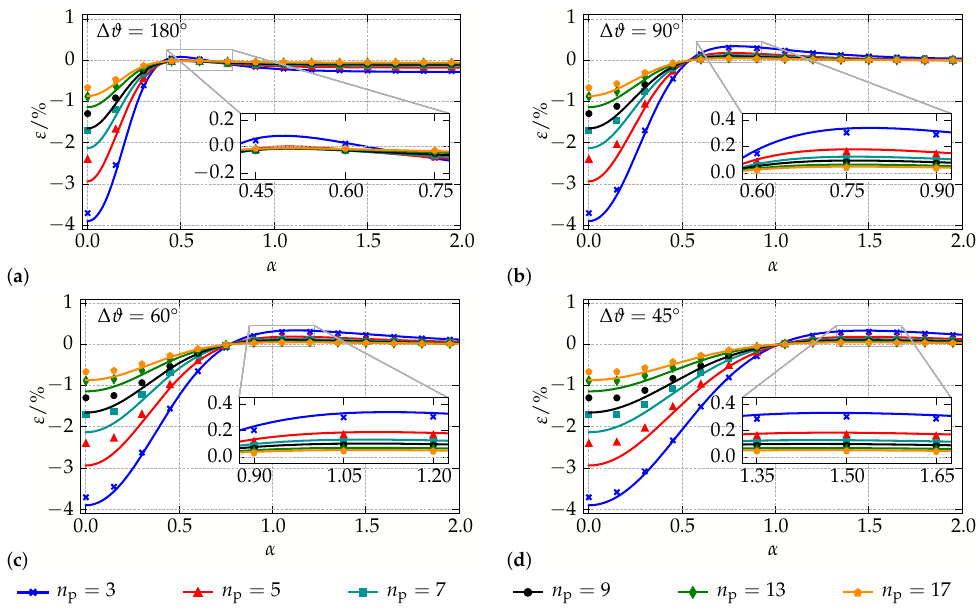
Figure 9. Results for helical chains with varying angle between adjacent particles: magneto- deformation plotted over the distance ratio α for ( a ) ∆ ϑ = 180°, ( b ) ∆ ϑ = 90°, ( c ) ∆ ϑ = 60°, and ( d ) ∆ ϑ =